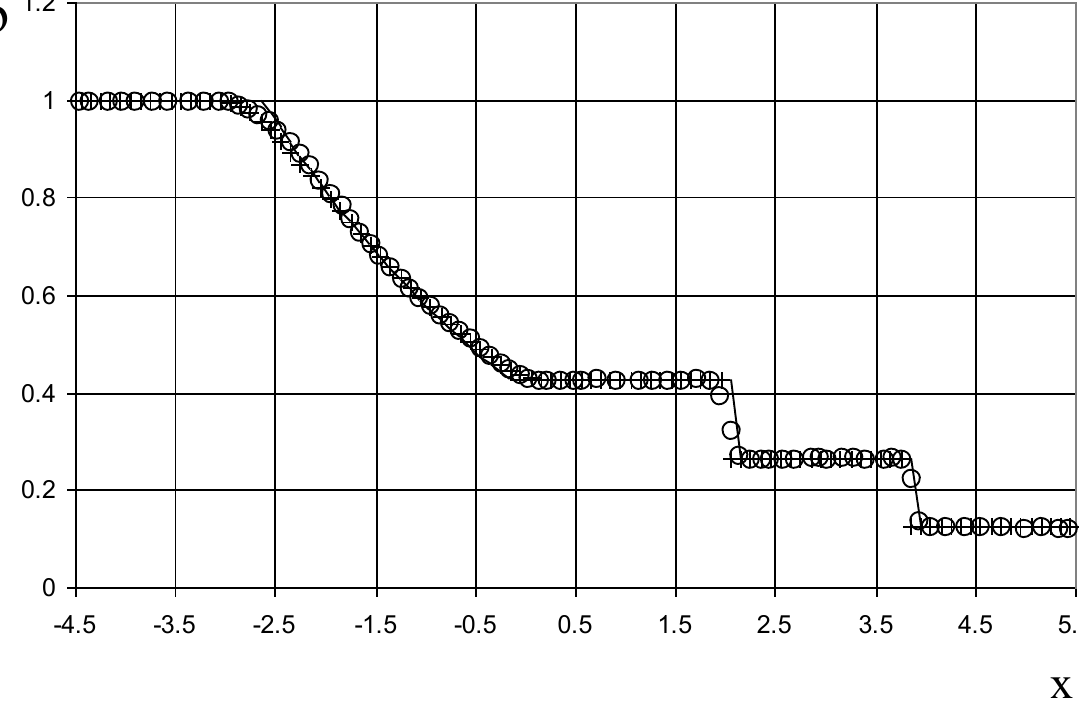
Figure 11. Density plot for the shock-tube problem of Sod: the exact solution (line), the ULT1C scheme of Harten (circle), and the present method (cross).